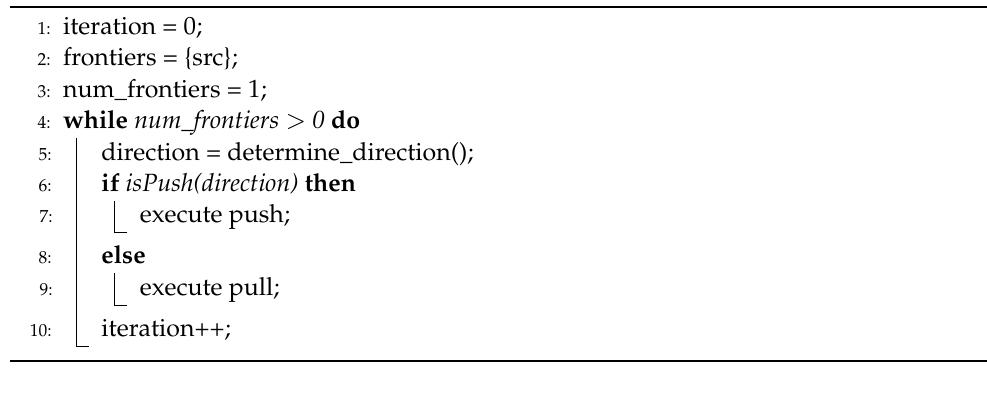
Algorithm 1 Direction-optimizing BFS.